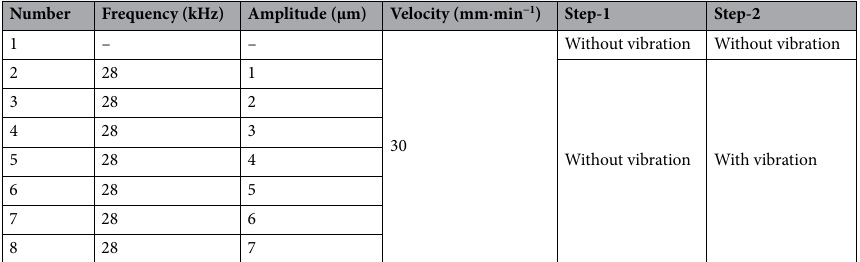
Table 6. Finite element analysis scheme.